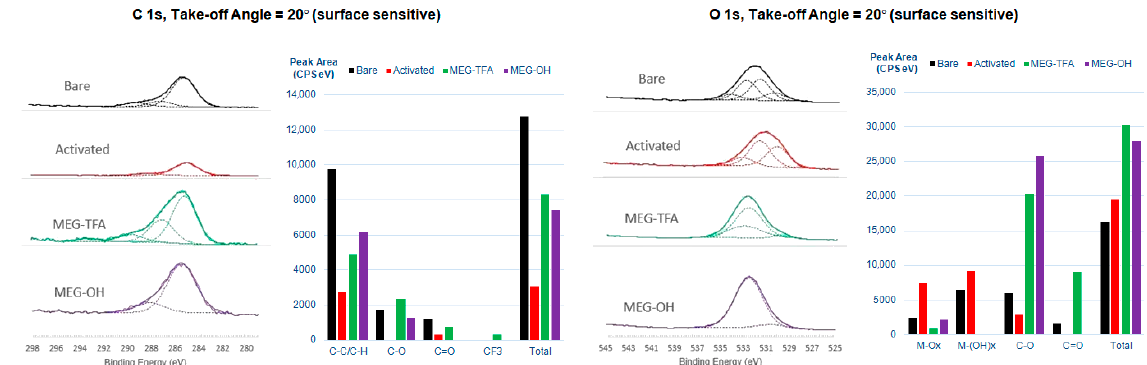
Figure 2. High-resolution XP spectra for carbon and oxygen scans of stainless steel through the stages of modification taken at a 20° take-off angle, additionally showing deconvolution of each signal.